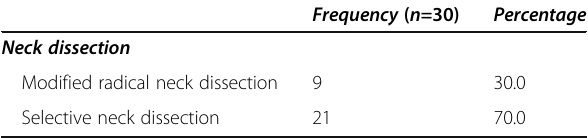
Table 1 Type of neck dissection performed